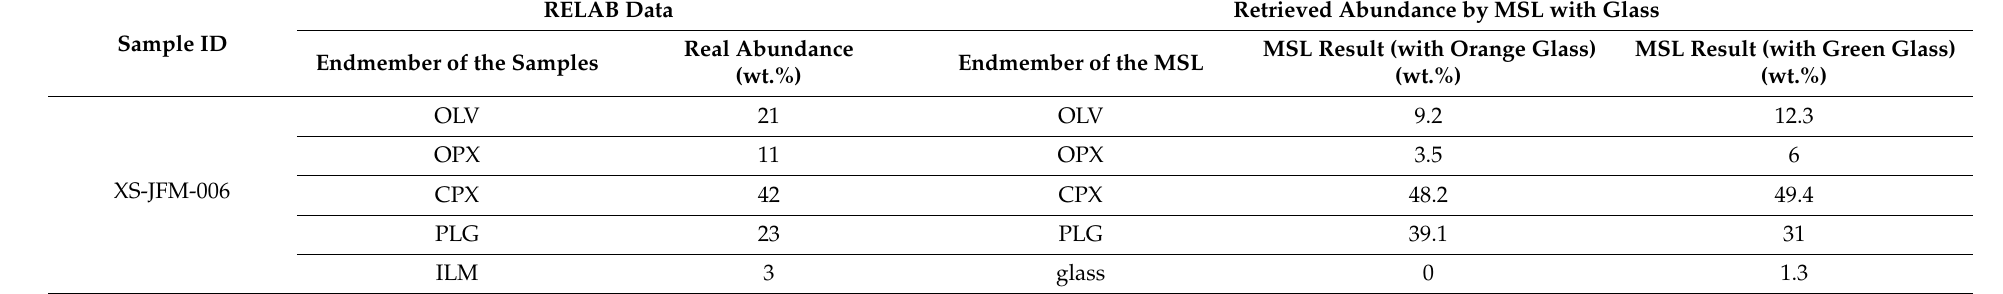
Table 4. The true and retrieved mineral abundances of four RELAB mixture samples. The samples of the RELAB contain five pure minerals with the sum of